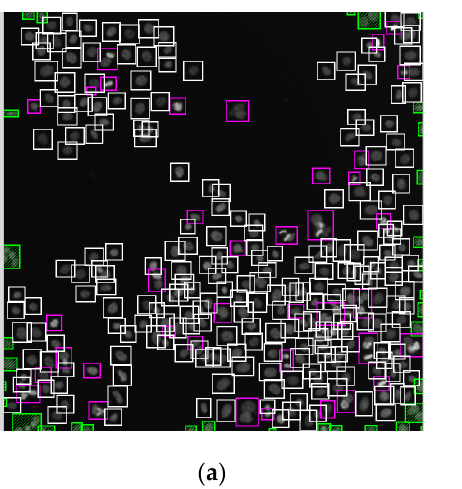
Table 1. The number of cell nuclei (experiment 1).